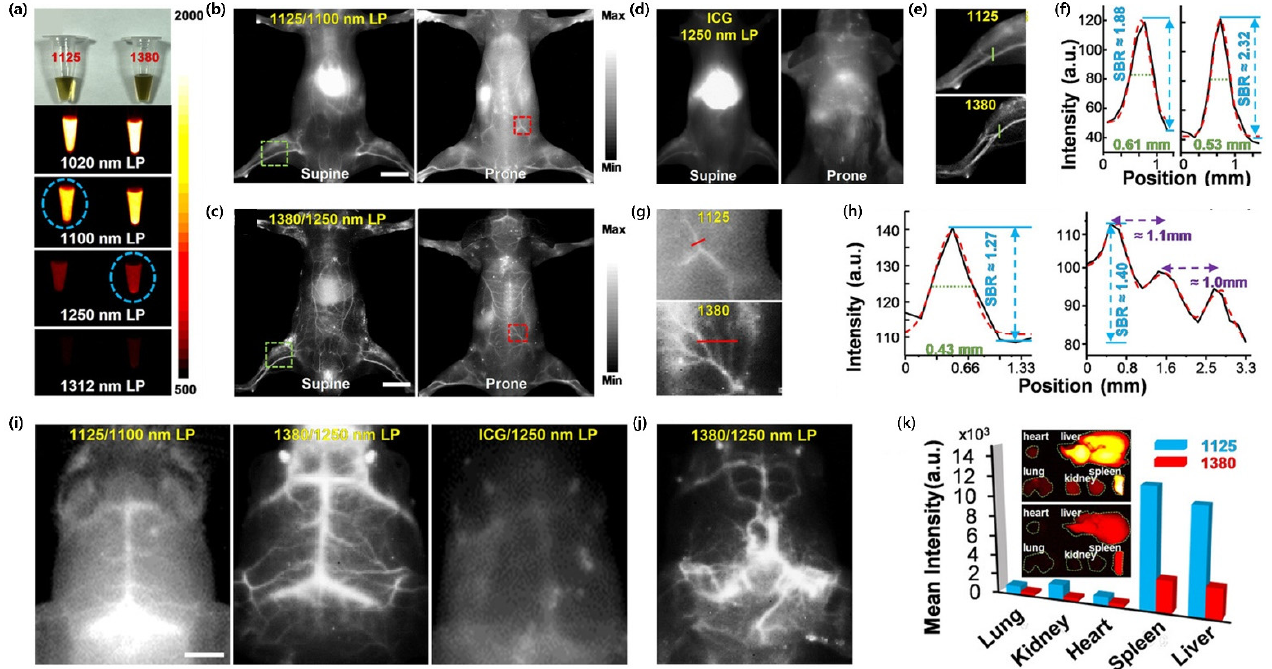
Figure 21. ( a ) Photographs of probe 24 Pdots ( left ) and probe 26 Pdots ( right ) under ambient light Figure 21. ( a ) Schematic illustration of NIR-I and NIR-II excited with in vivo 2PF imaging of the (first panel) and under 808 nm laser excitation with a 1020 nm LP filter (second panel), 1100 nm LP mouse brain. ( b ) Normalized UV–vis absorption spectra of probe 48 Pdots in aqueous media; inset is filter (third panel), 1250 nm LP filter (fourth panel), and 1312 nm LP filter (fifth panel). ( b ) Whole- the digital photograph of the two probe 48 Pdots in cuvettes. ( c ) Photoluminescence spectra of probe body imaging of live mice intravenously injected with probe 24 Pdots in supine ( left ) and prone 48 Pdots at a concentration of 10 µ g mL − 1 in aqueous solution; the inset shows a digital photograph ( right ) positions with a 1100 nm LP filter. ( c ) Whole-body imaging of live mice intravenously in- of the two probe 48 Pdots in cuvettes under a UV lamp. In vivo 2PF imaging of probe 48 Pdot- jected with probe 26 Pdots in supine ( left ) and prone ( right ) positions with a 1250 nm LP filter. ( d ) stained mouse brain blood vessels with an intact skull. ( d , e ) Three-dimensional reconstructed second Whole-body imaging of live mice intravenously injected with ICG in supine ( left ) and prone ( right ) harmonic generation (SHG) images of the mouse skull. ( f – k ) 2PF images of probe 48 Pdot-stained positions with a 1250 nm LP filter. ( e ) Enlarged view of the mouse hindlimb vasculature in the green brain blood vessels at various vertical depths. ( l – n ) Three-dimensional reconstructed 2PF images squares of ( b ) ( upper panel) and ( c ) ( bottom panel), respectively. ( f ) Cross-sectional intensity pro- of the brain blood vessels. ( o ) Three-dimensional reconstructed image showing the position of the files along the green lines in ( e ) for probe 24 Pdots ( left ) and probe 26 Pdots ( right ), respectively. ( g ) Enlarged view of the area close to the spinal cord in the red squares of ( b ) ( upper panel) and ( c ) skull and the brain blood vessels network below the skull. Excitation for SHG: 950 nm; excitation for 2PF: 1200 nm. Emissions were collected within 455–500 nm for SHG and 660–750 nm for CPdots1. Each frame was acquired in 3.22 s. The length of scale bars in all images is 100 µ m. Reprinted